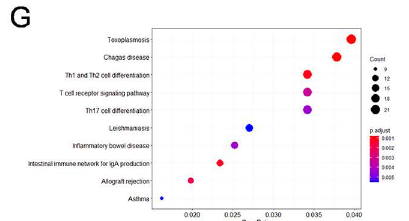
Figure 3. Single-gene analysis of HIF1A based on chronic lymphocytic leukemia (CLL) transcriptome data in the Gene Expression Omnibus (GEO) database. ( A ) Heat map of differential genes (top 100; dark red indicates larger logFC values and dark blue indicates smaller logFC values. ( B ) Volcano plot of differential gene analysis. Genes with logFC greater than 4 are labeled in the graph. ( C ) Survival analysis of the GSE22762 dataset showing high expression of HIF1A protein (high expression defined by median) indicates good prognosis for CLL patients. ( D , E ) Expression of HIF1A and HIF1AN proteins in CLL patients and normal controls. HIF1A protein levels were low in CLL patients and high in normal controls, and HIF1AN protein levels were high in CLL patients and low in normal controls (Wilcoxon test). ( F ) Gene ontology (GO) analysis of 2000 genes with the greatest difference between EGLN1 knockdown and the control group. Positive regulation of cytokine production was enriched in biological process in GO analysis. ( G ) Kyoto Encyclopedia of Genes and Genomes (KEGG) analysis of the 2000 genes with the greatest difference between EGLN1 knockdown and the control group. The T cell receptor signaling pathway was enriched ( *** means p ≤